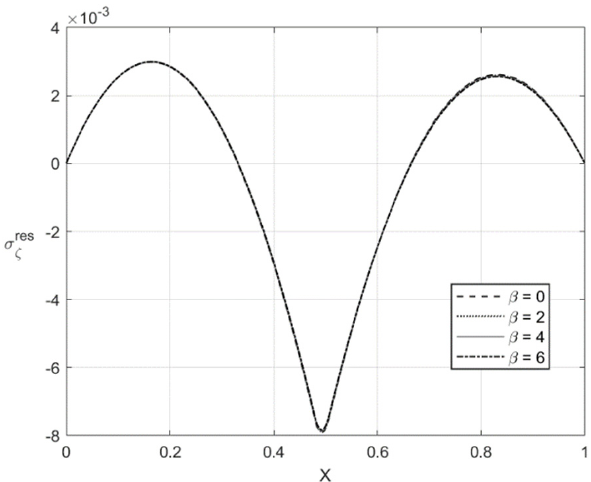
σ = 0.06 H r = res at , 0 f , ζ CD